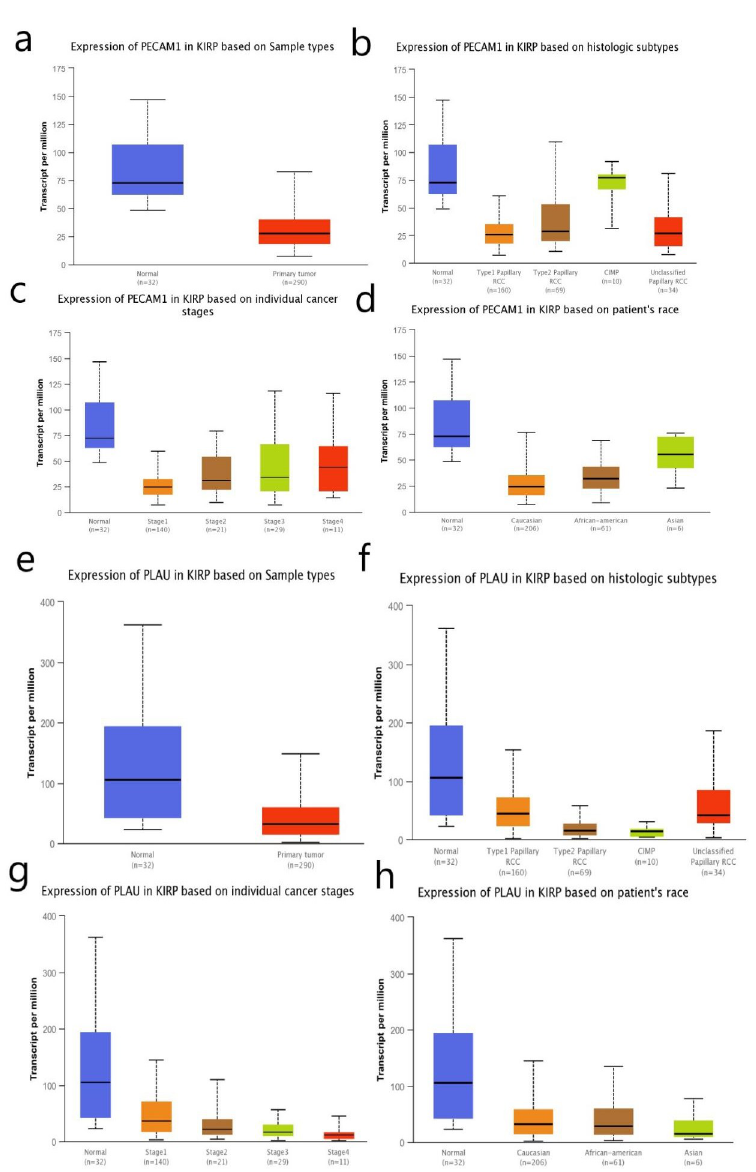
Fig 7. The online database UALCAN was applied to analyse the expression of the two indicated genes based on tissue type (PRCC tissue versus normal tissue), stage, subtype and race. a-d show data for PECAM1, and e-h show data for